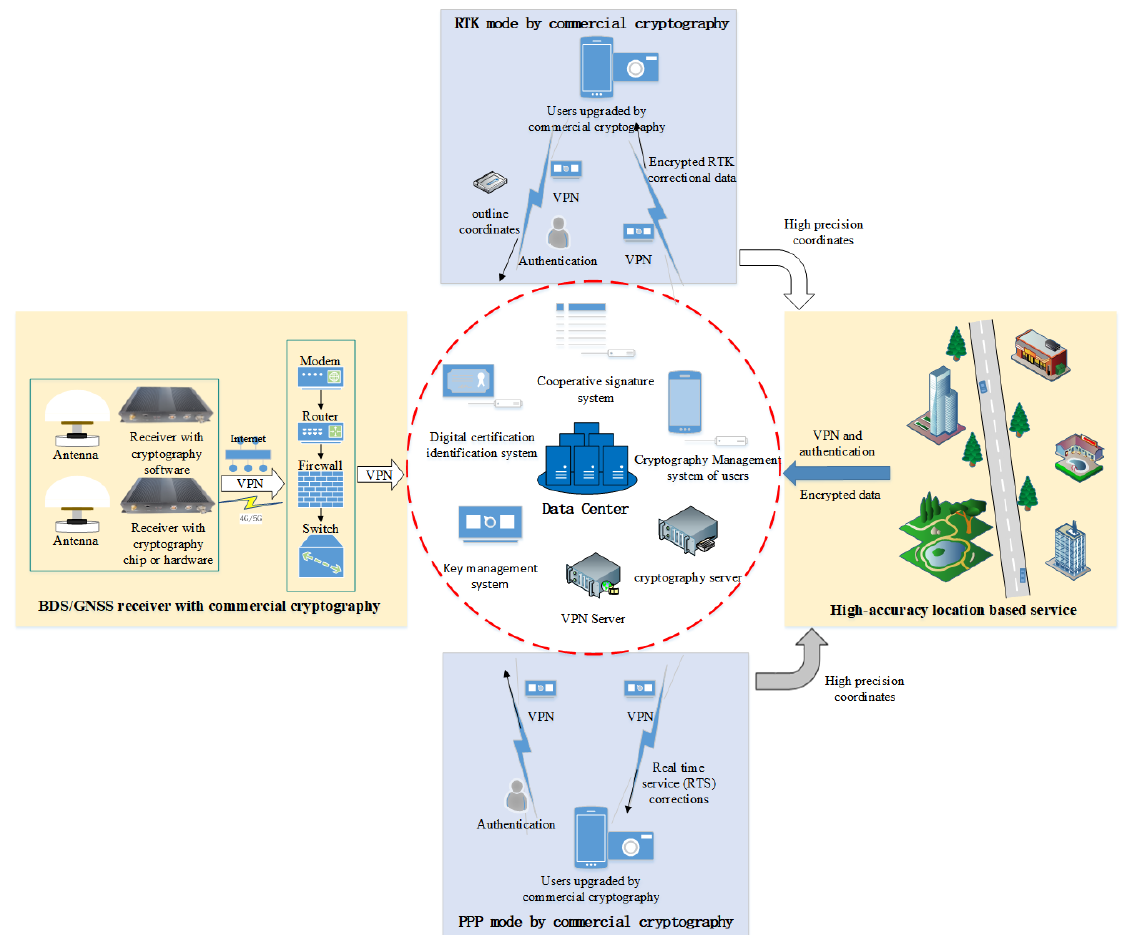
Figure 2. Commercial cryptography updating plan.